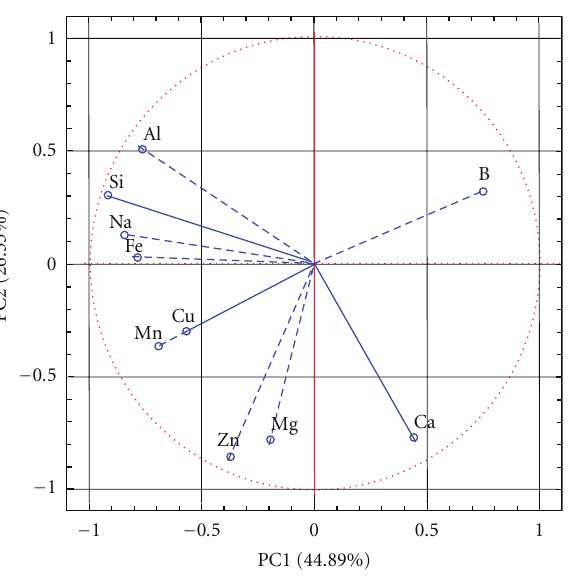
Figure 5: Plot of the relative responses (Ra) of the three sensors.